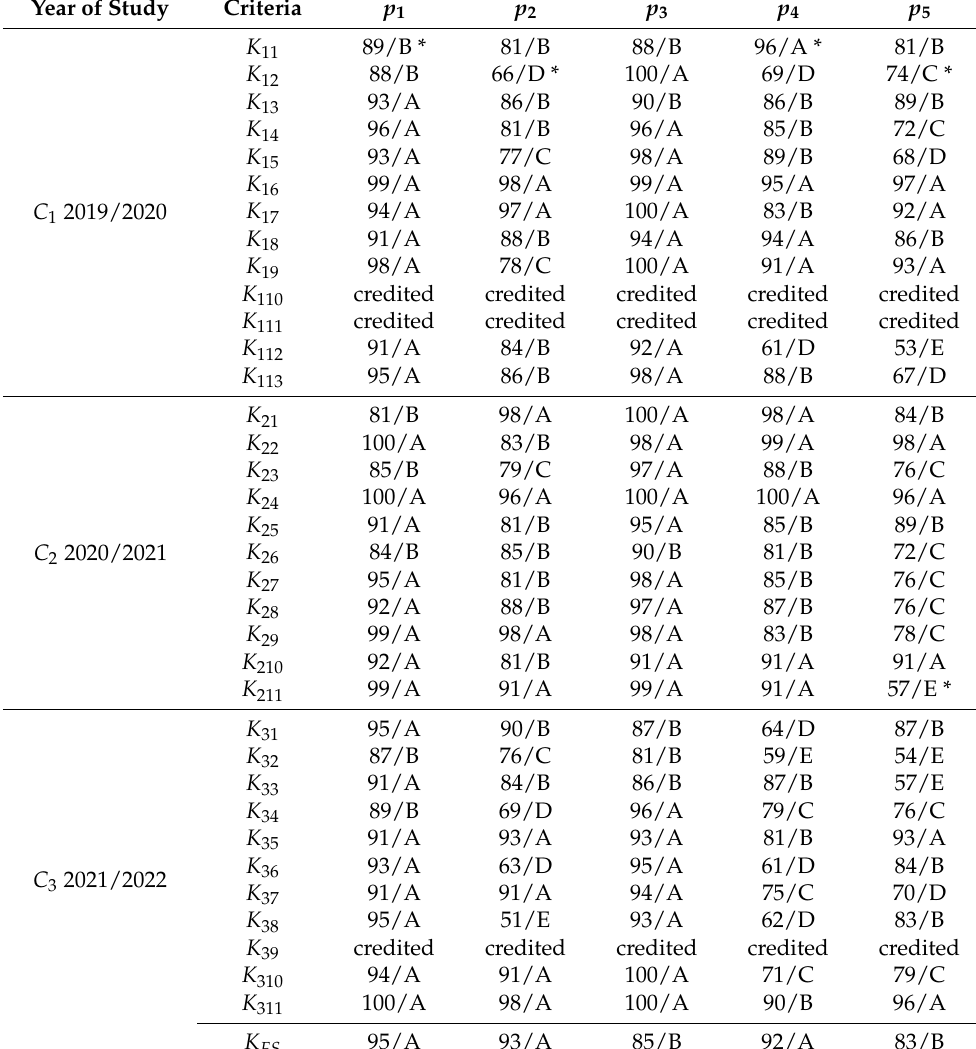
Table 1. Input data on the learning outcomes of students (pilots). Year of